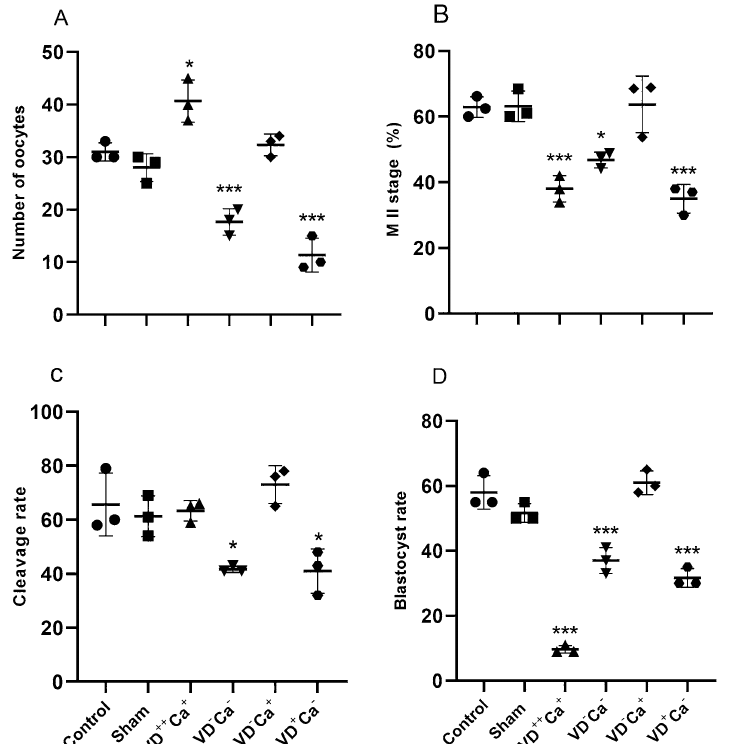
Figure 2. Effect of treatments on: ( A ) number of oocytes collected, ( B ) percentage of MII mature oocytes, ( C ) cleavage rate and ( D ) blastocysts rate. * p < 0.05, ** p < 0.001, and *** p <